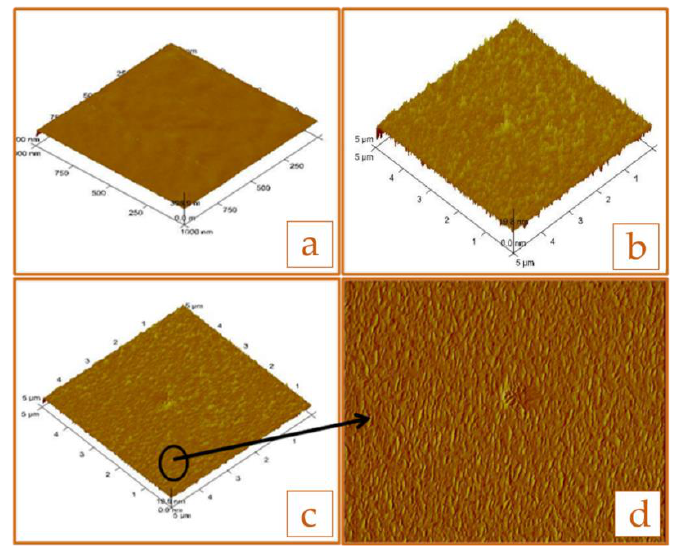
Figure 5. ( a ) AFM image of the pure chitosan film; ( b ) AFM image of the grafted chitosan film. ( c , d ) AFM image of the grafted chitosan–Pt–Fe 3 O 4 hybrid nanoparticles nanocomposite film.